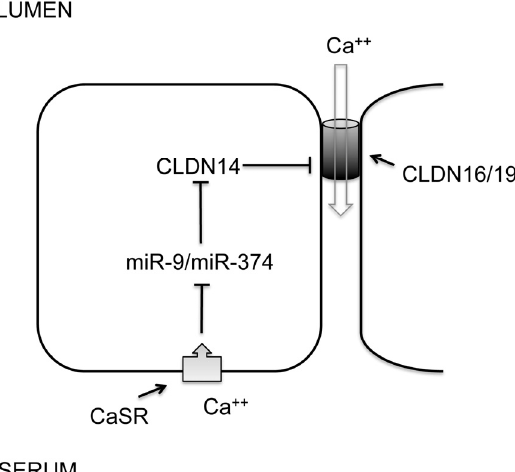
Figure 3. The role of microRNA in renal CaSR signaling. A feedback loop of CaSR signaling in the thick ascending limb of Henle’s loop (TALH) regulates urinary excretion of Ca ++ through transcriptional regulation of miR-9 and miR-374. MicroRNAs in turn negatively regulate the expression level of claudin-14 through mRNA decay and translational repression. Claudin-14 directly binds to claudin-16 and inhibits its cation permeability to urinary Ca ++